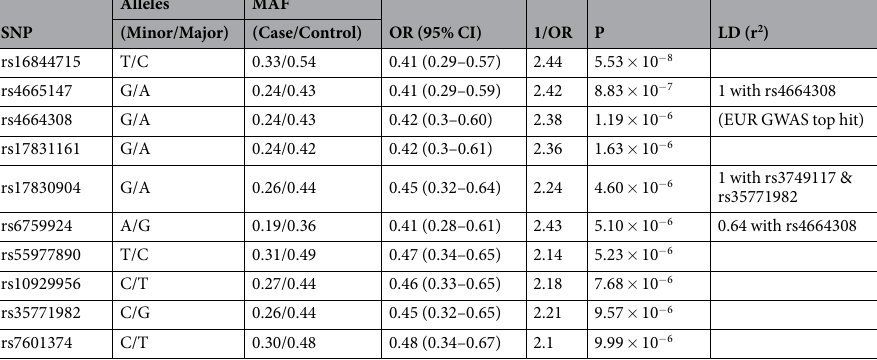
Table 1. Association results of SNPs in PLA2R1 with P < 10 − 5 in the initial genome-wide genotyping results. (98 IMN vs. 413 controls). rs4664308 is the top SNP and rs3749117 is the second top SNP in European